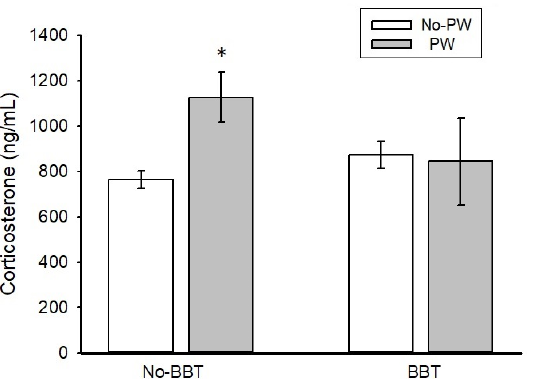
Figure 2. Corticosterone levels of Wistar Kyoto rats subjected to progesterone withdrawal. Each bar represents the mean ± standard error of the mean in ng/mL n = 4–6 per group. * p < 0.05 versus No ‐ PW = no progesterone withdrawal (vehicle ‐ treated rats); PW = progesterone withdrawal.